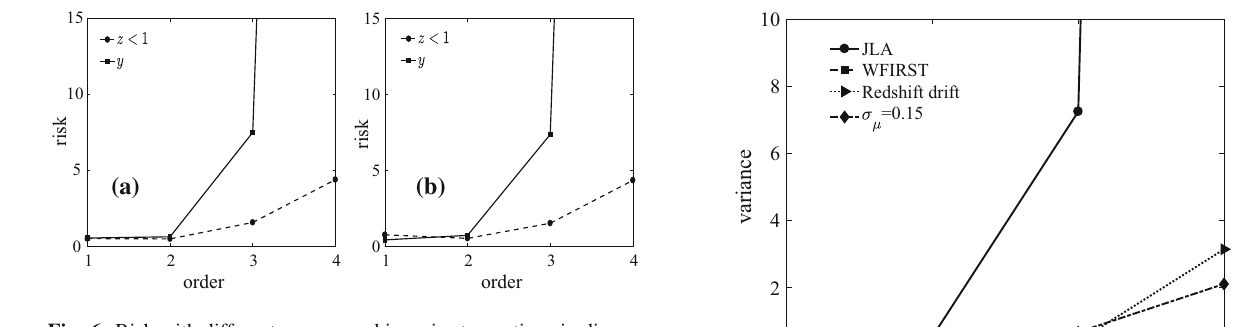
Fig. 6 Risk with different cosmographic series truncations in diverse fiducial models. The panel ( a ) is for the (cid:2) CDM model, and the panel ( b ) is for the w CDM model